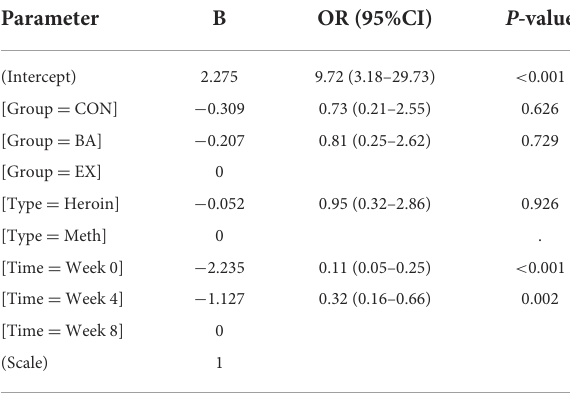
TABLE 3 Analysis of VAS score distribution by generalized estimating